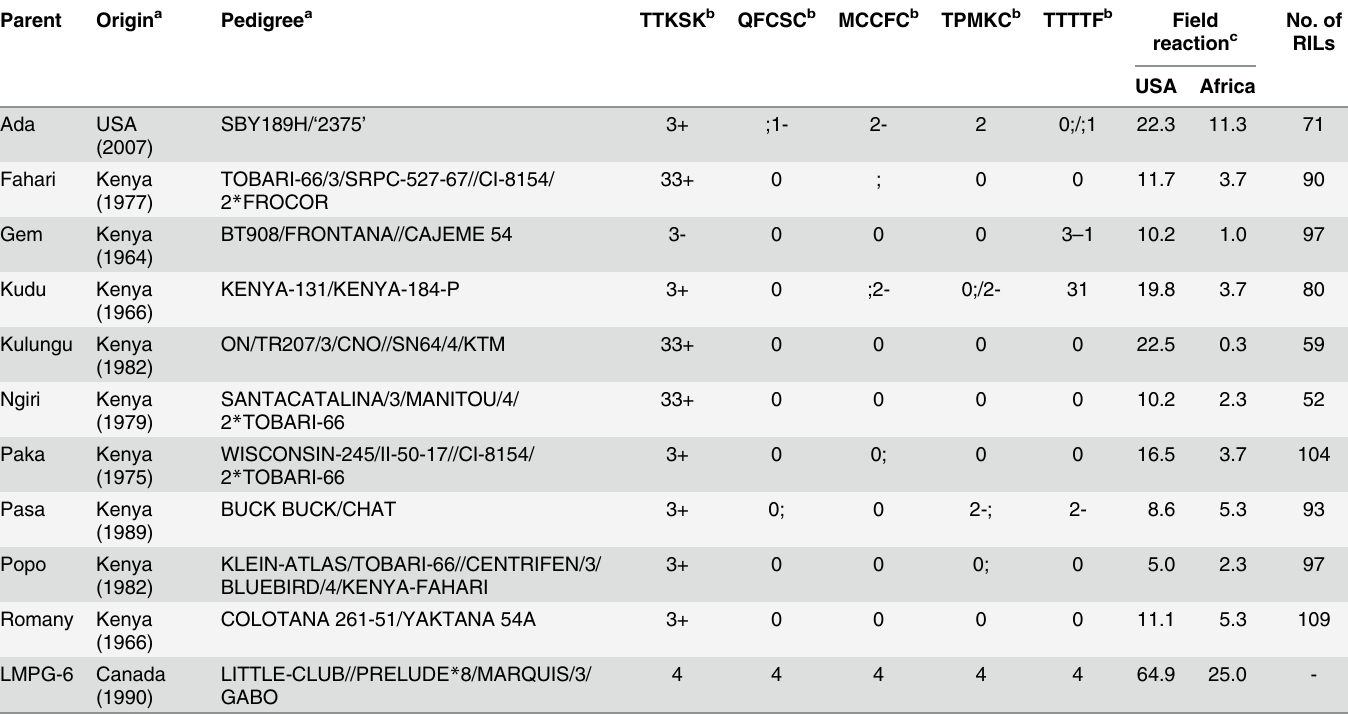
Table 1. Origin, pedigree, and stem rust reaction of parent lines used to develop the NAM